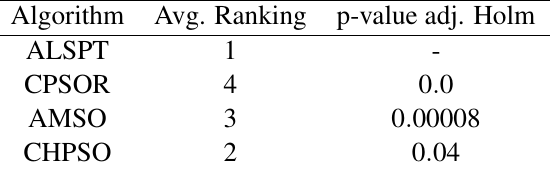
Table 11. Average rankings provided by the Friedman’s non-parametric test for ALSPT, CPSOR, AMSO and CH- PSO considering the results over 17 MPB configurations ( s = { 1 , 2 , 3 , 4 , 5 } ; m = { 5 , 10 , 20 , 30 , 50 , 100 , 200 } ; n = { 5 , 10 , 20 , 30 , 50 } ), and adjusted p-value according to the Holm’s post-hoc procedure using ALSPT as control algorithm.